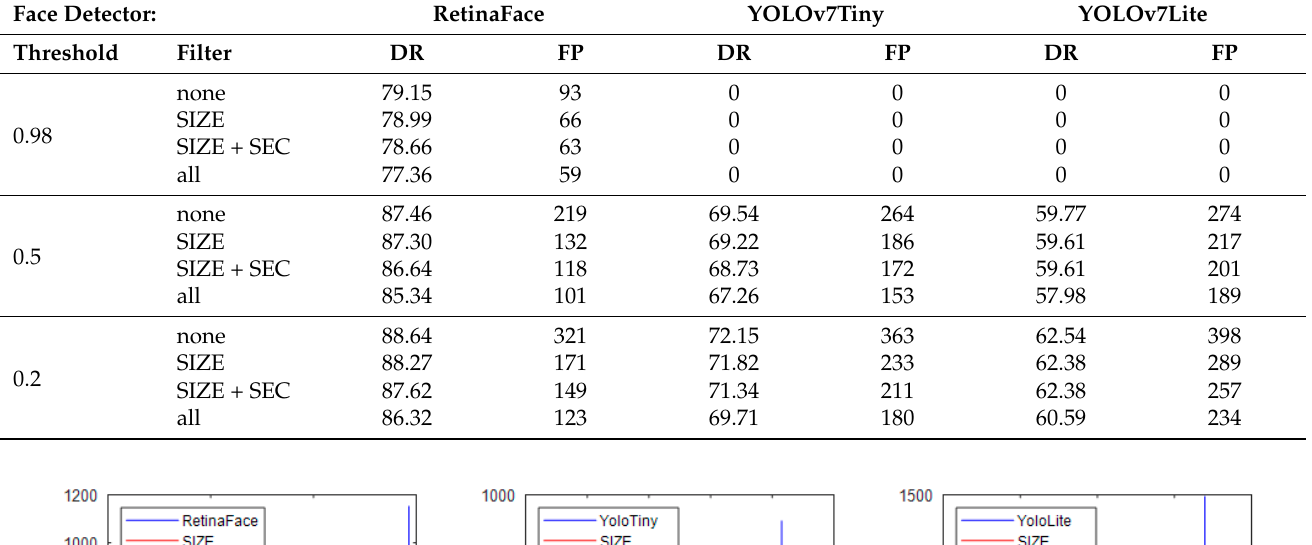
Table 4. Performance of face detection methods combined by filtering steps on the fog-perturbed images.